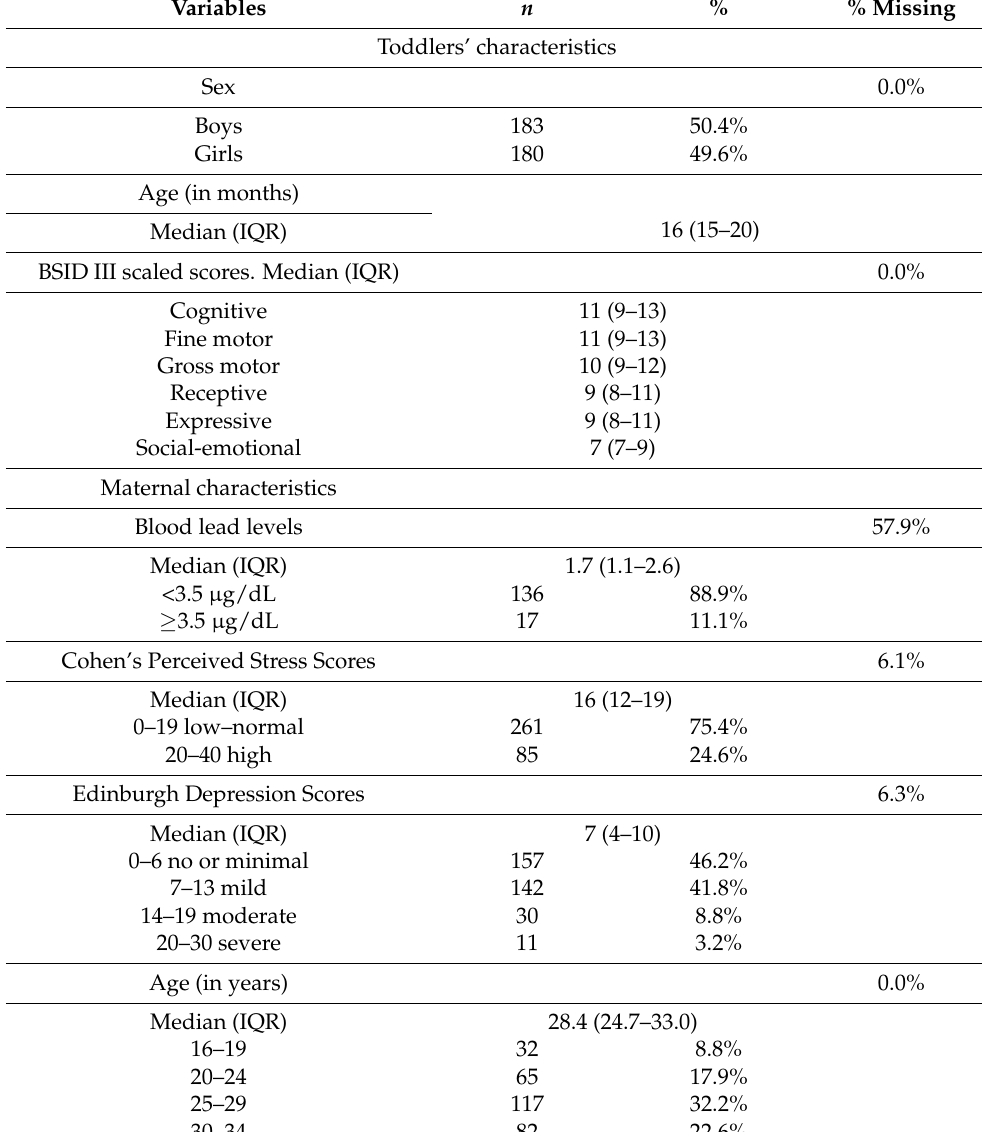
Table 1. General characteristics of the CCREOH subcohort Paramaribo and Wanica ( n = 363). Variables n % %